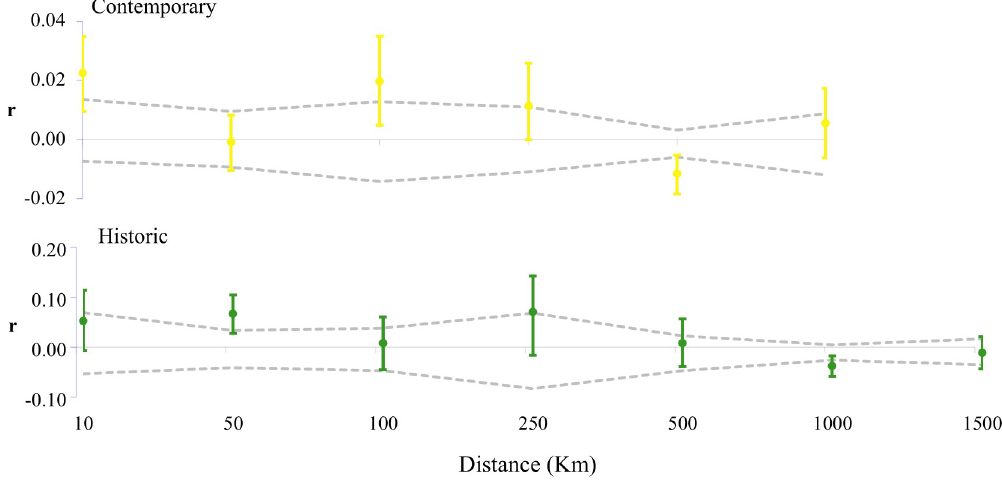
Fig 5. Spatial autocorrelation (r) in genomic similarity at varying distance classes within the historic and contemporary regent honeyeater population. Error bars (95% confidence intervals) at each distance class estimated via 999 bootstraps of sample pairs. Dashed lines denote simulated 95% upper and lower confidence intervals, assuming random distribution of regent honeyeaters within each time period.